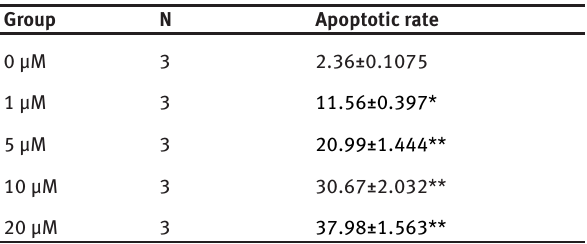
Table 1: The apoptosis rate of cells increased with the increase of folic acid